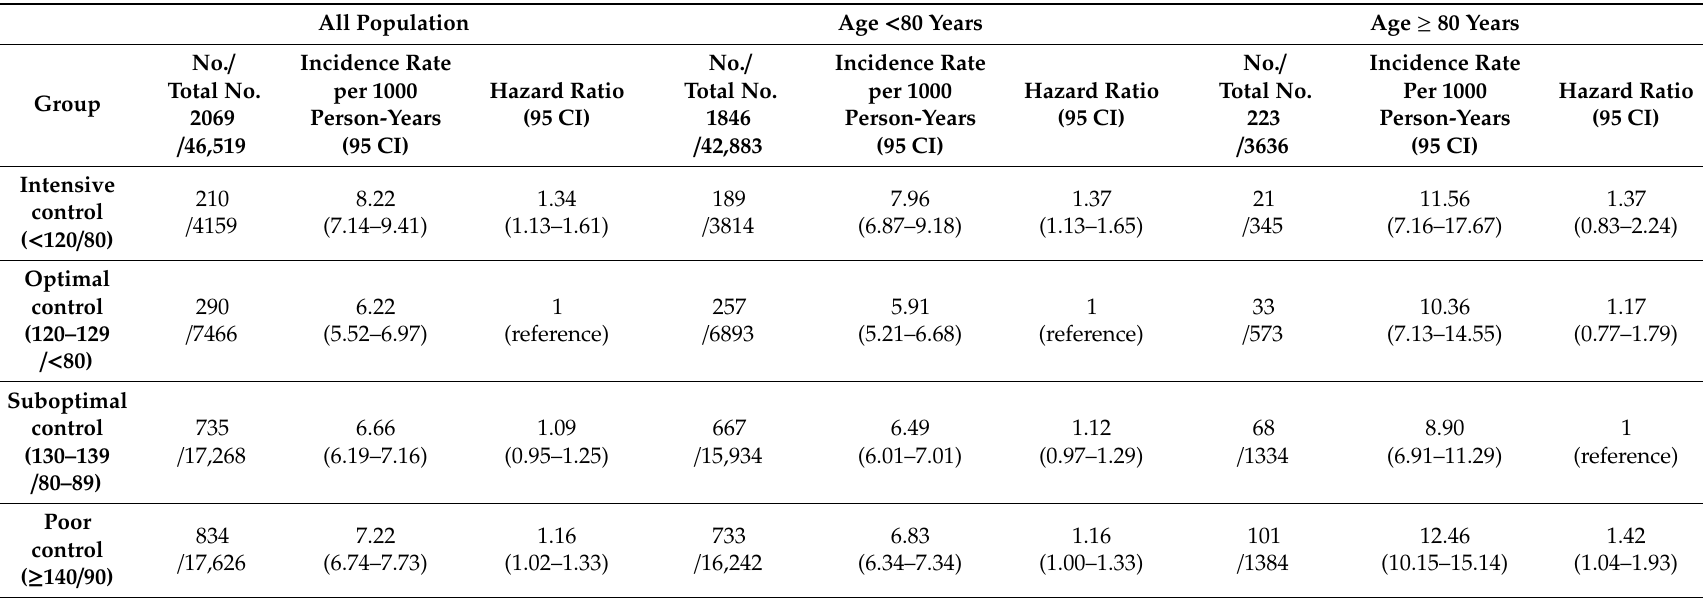
Table 3. Incidence Rate of Atrial Fibrillation According to Blood Pressure in Patients with Treated